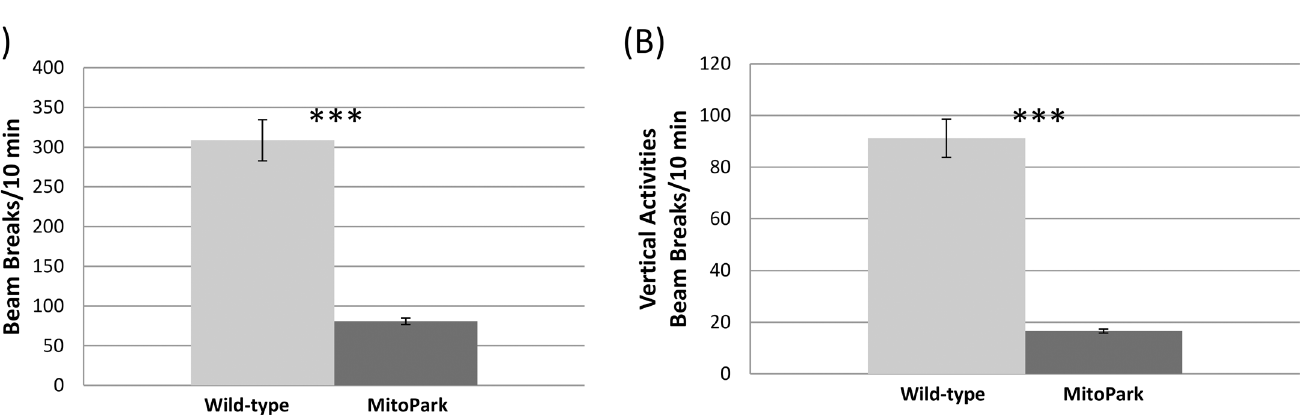
PLOS ONE | DOI:10.1371/journal.pone.0151884 March 22,